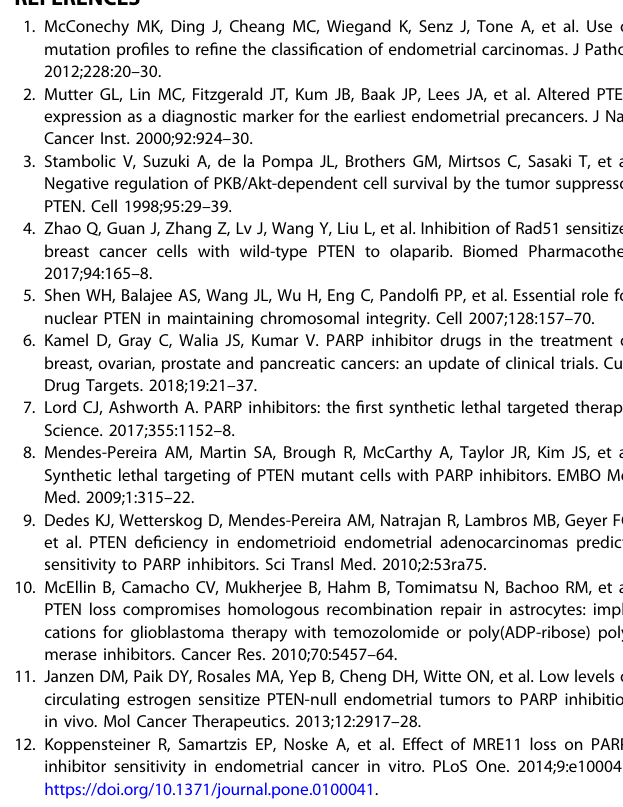
Fig. 5 Combined NPB-PARPi treatment suppresses the growth of AN3CA-GFP-derived xenografts and patient-derived EC organoids (PDECO) in ex vivo culture. A AN3CA-EGFP (5 × 10 6 ) cells were injected subcutaneously into the fl ank of 5-week-old BALB/c athymic mice. When the xenograft reached ~100 m 3 the mice were randomized into the 4 indicated treatment groups ( n = 8 each group). Mice were treated daily with vehicle (V), 20 mg/kg NPB (N), 50 mg/kg Olaparib (O), or a combination of NPB-Olaparib by i.p. injection. Left upper: xenograft growth was monitored daily by measurement of volume. Left lower: Mean weights of animals in each treatment group are indicated. Animal weight was monitored daily. Arrows indicate the start and the end of the treatment. Right upper: bioluminescence subcutaneous surface of AN3CA-EGFP xenograft in each group was observed using a fl uorescence imaging system (IVIS Spectrum, PerkinElmer, US) on the 18 th day after the start of injection. Right lower: Mean xenograft weight of each treatment group after sacri fi ce. Results represent the mean ± SEM of eight animals. B Representative images of bioluminescence detection for lymph node, lung, and liver regions. EGFP negative animal organ tissue was used as a negative control. Bioluminescence intensity was quanti fi ed for the evaluation of metastases. C Effects of NPB (N), PARP inhibitors (Olaparib = O, Rucaparib = R, Talazoparib = T), or combination treatment for 9 days in EC patient-derived organoids (PDOs) was evaluated using the ApoTox-Glo Triplex Assay Kit for survival fraction (SF) and CASPASE3/7 activity. Organoid growth was determined by the counting of the number of organoids with diameters >100 µm number on the 7th day of culture; Scale bars: 100 µm. Days in red color meant drug administration on that day. Red color arrow highlights the apoptotic PDOs. Columns are mean of samples in each group; bars, ±SD. * p < 0.05, ** p < 0.01, *** p <